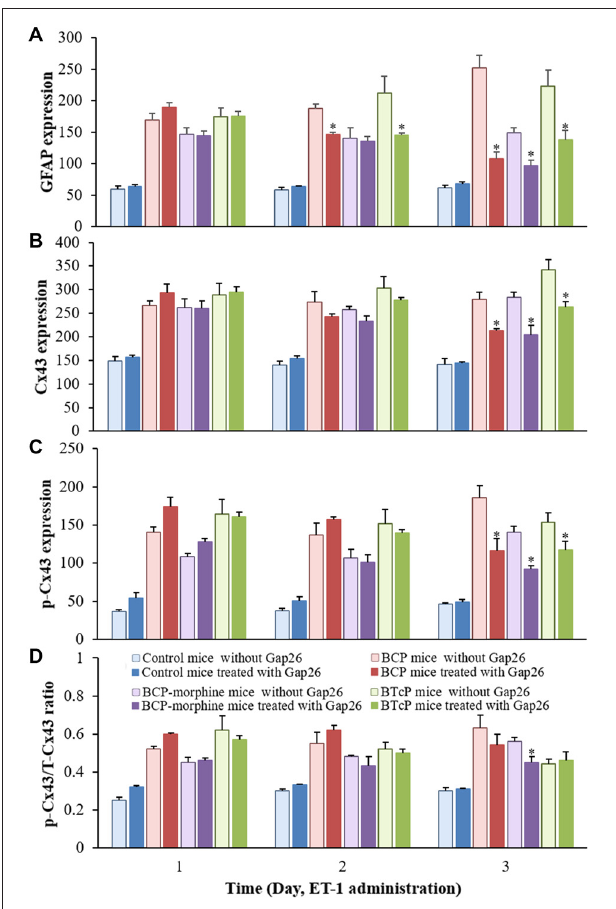
FIGURE 6 | Comparison of the protein expressions of GFAP (A) , Cx43 (B) , p-Cx43 (C) and the ratio of p-CX43/T-Cx43 (D) in normal, BCP, BCP-morphine and BTcP mice with or without Gap26 treatment. Gap26 (5 mg/kg/day) was administered by intrathecal injection once a day for 3 days in the last 3 days of experiment (PIDs 16–18). GFAP, Cx43 and p-Cx43 were analyzed by Western blotting and the ratio of p-CX43/T-Cx43p was calculated from phosphonated Cx43 and total Cx43. Five mice were used for each group. ∗ P < 0.05, vs. no Gap26 treatment. The data were combined with the data of Figures 2 , 5